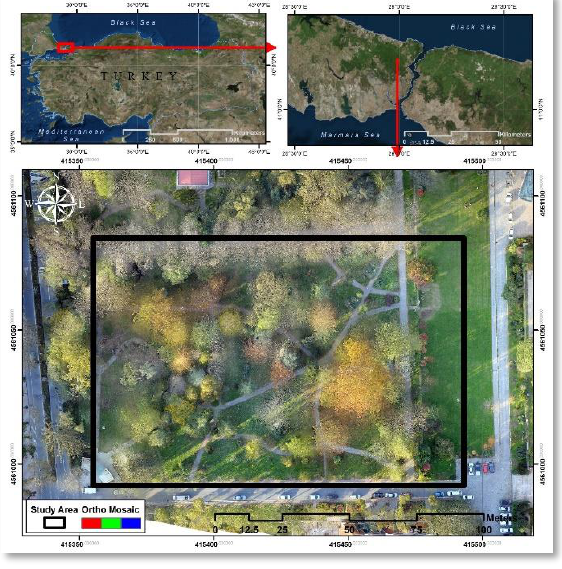
Figure 1. Location map of the study area All raw scans were registered by using Z+F Laser Control